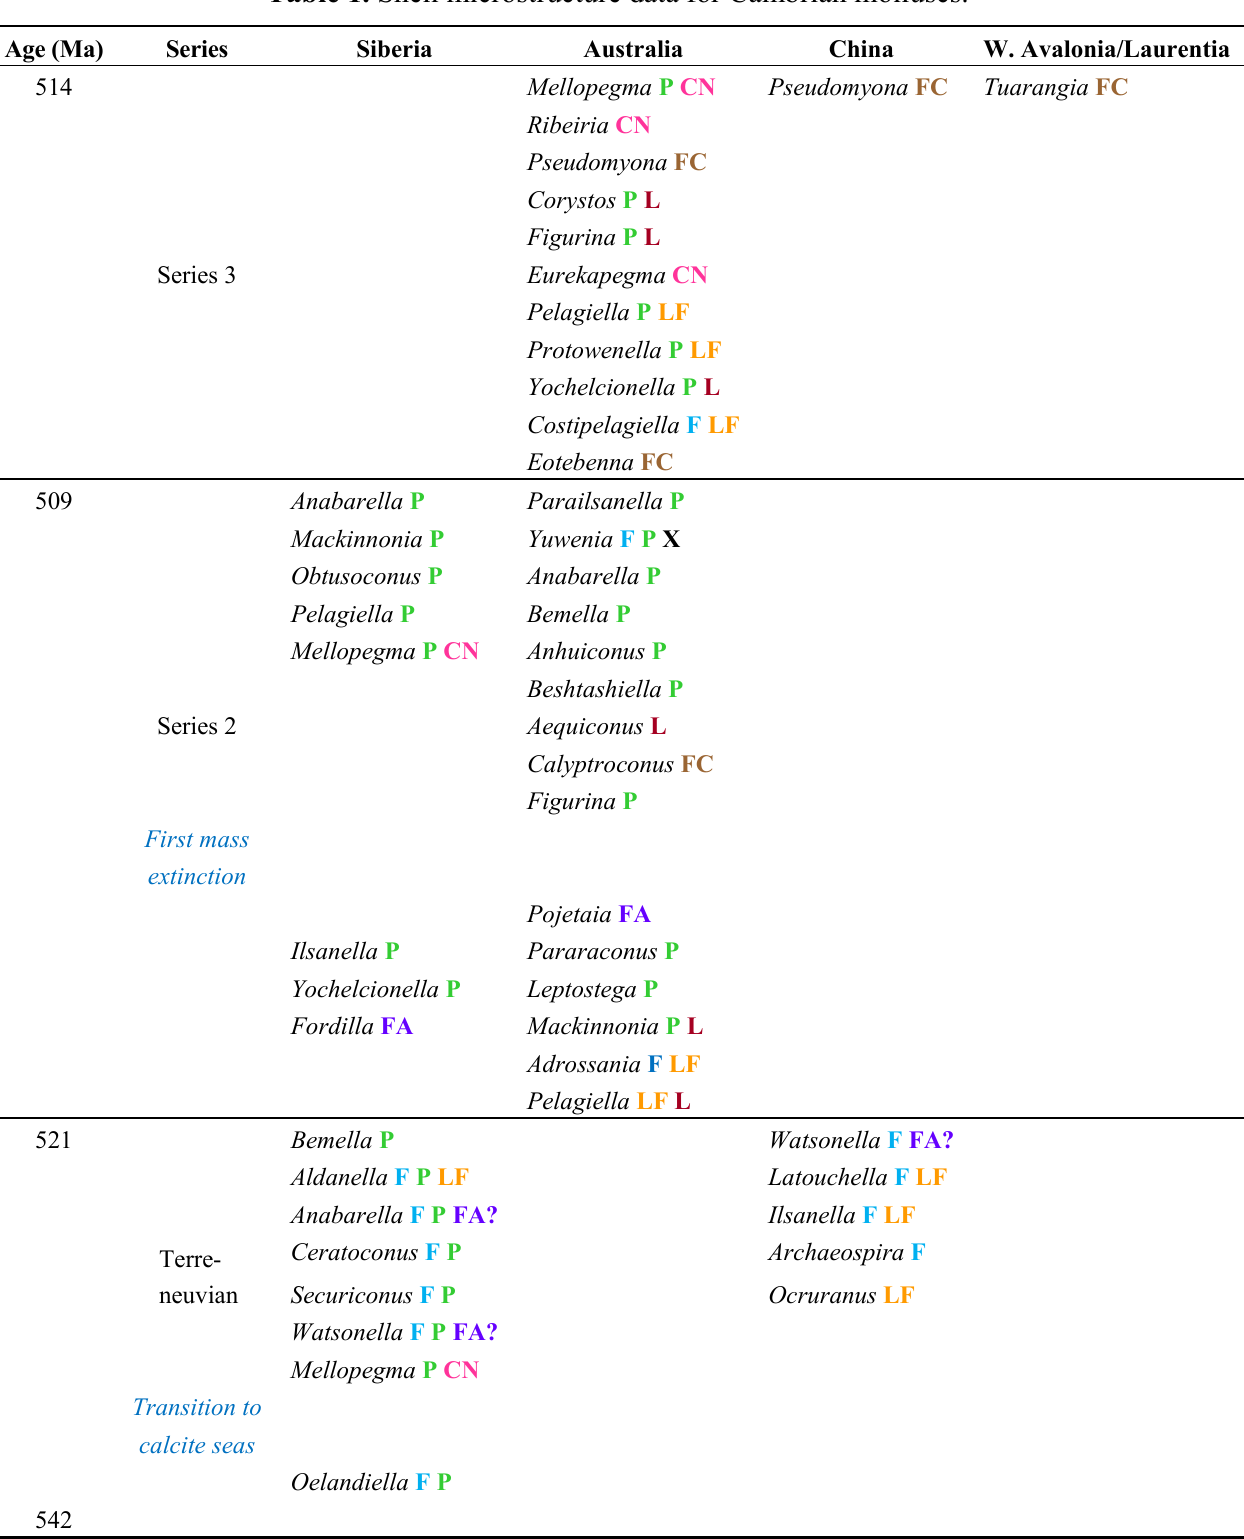
Table 1. Shell microstructure data for Cambrian